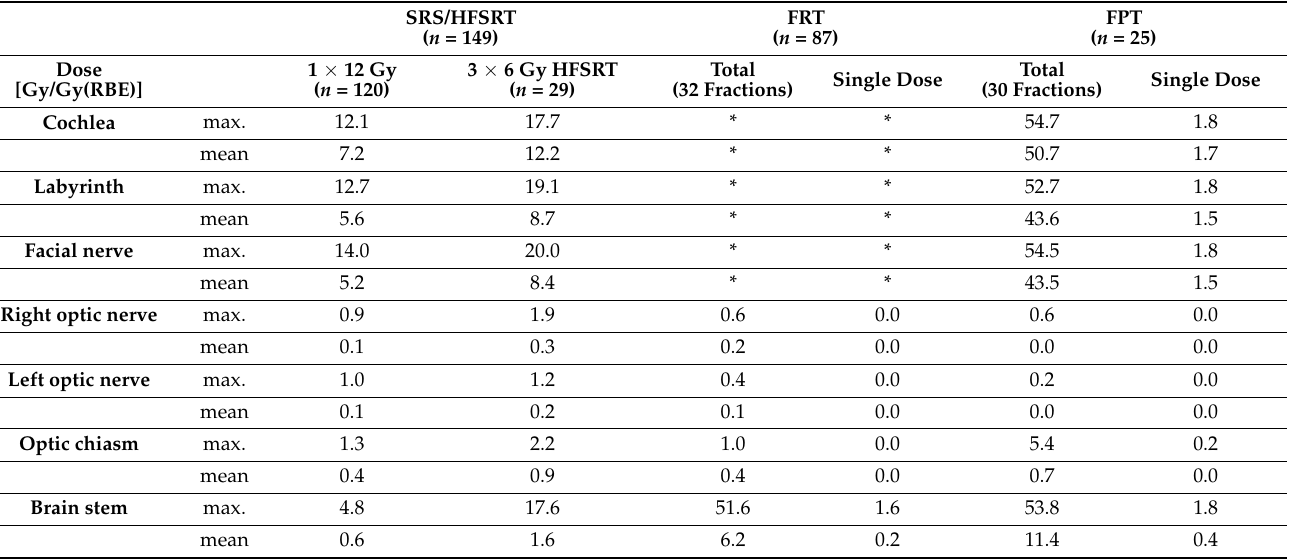
Table 3. Median doses of organs at